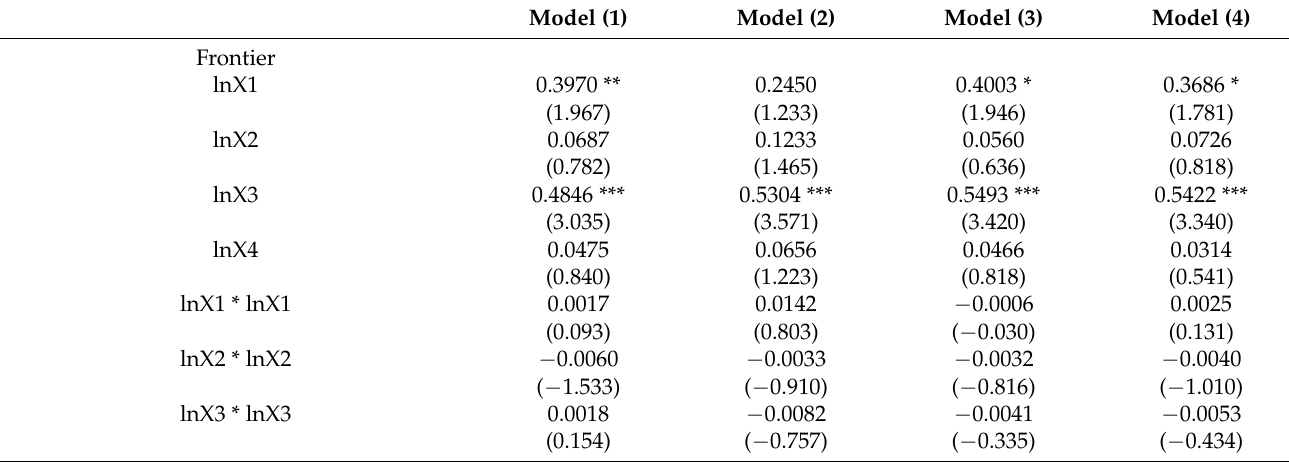
Table 8. Analysis of the effect of LF on technical